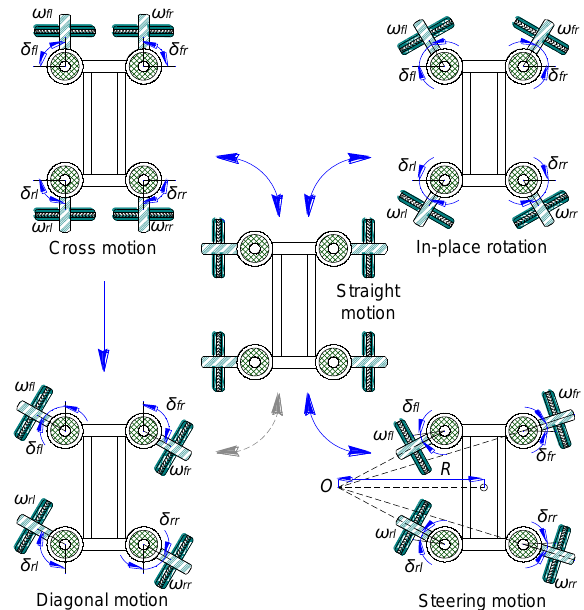
Figure 2. Schematic diagram of flexible chassis (FC) motion mode models. O is the turning center. R is the FC steering motion turning radius. Blue represents direct switching between two motion modes, and the gray arrow indicates that it cannot be switched directly.